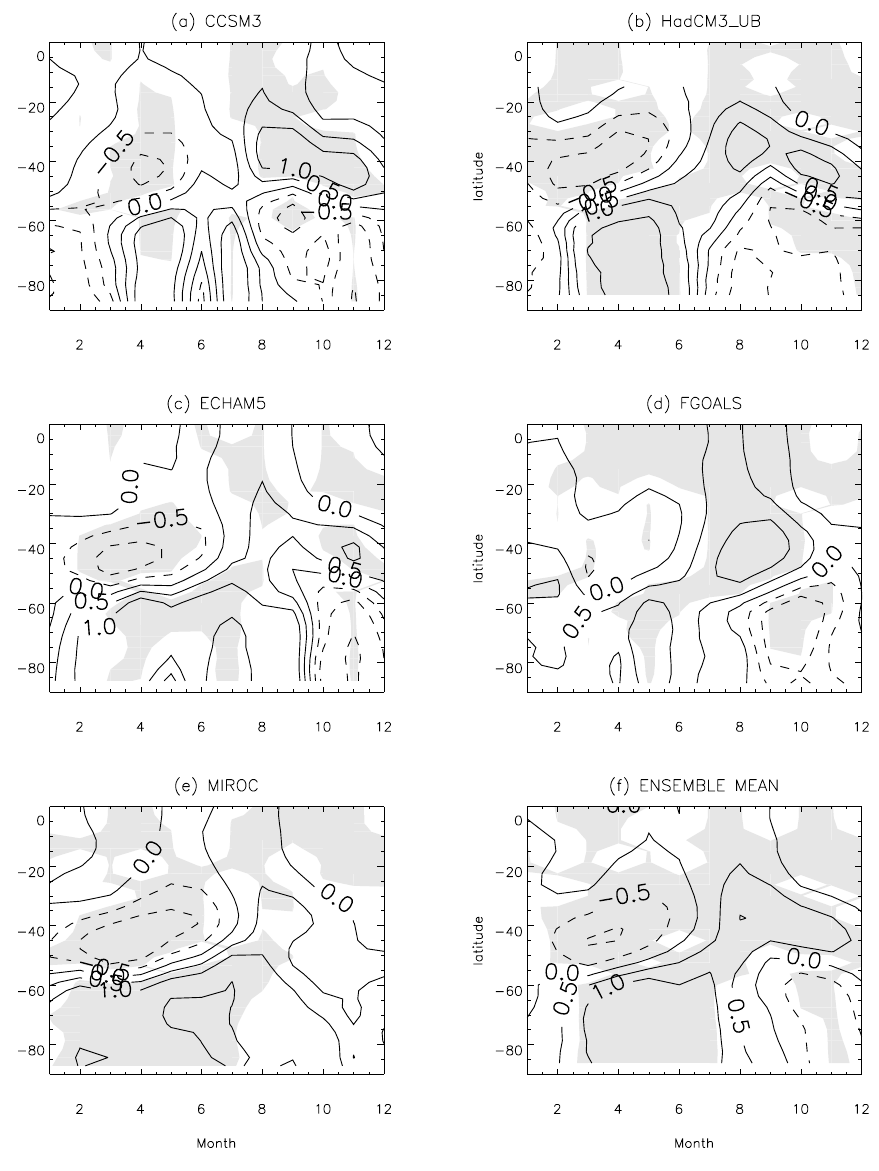
Fig. 9. Zonal mean difference in sea level pressure (hPa) between the PMIP2 Mid-Holocene and control runs for (a) CCSM3, (b) HadCM3 UB, (c) ECHAM5, (d) FGOALS, (e) MIROC and (f) the ensemble mean for each calendar month. Refer to Table 1 for more details on each model. Solid (dashed) lines indicate positive (negative) changes and statistically significant changes ( p ≤ 0.05) are shaded